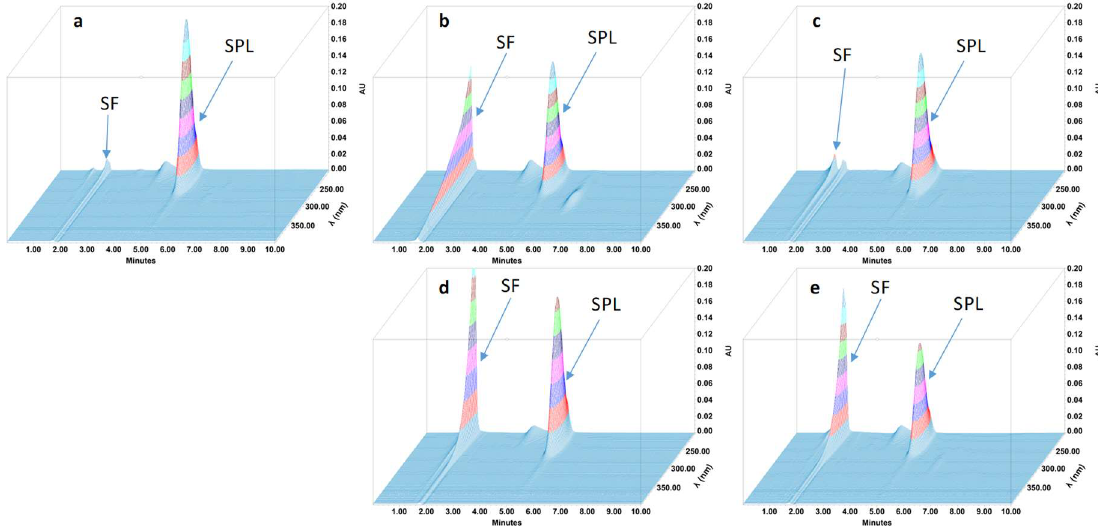
Figure 4. Three-dimensional chromatograms obtained for spironolactone (SPL) oral suspensions after applying different stress conditions. ( a ) No stress; ( b ) HCl 0.5 M at 80 °C for 1 h; ( c ) NaOH 0.1 M at 80 °C for 5 min; ( d ) H 2 O 2 3% at 80 °C 4 h; ( e ) 80 °C for 4 h. SF: solvent front. Table 4. Attributes related to three-dimensional chromatogram peaks obtained during a forced degradation study.